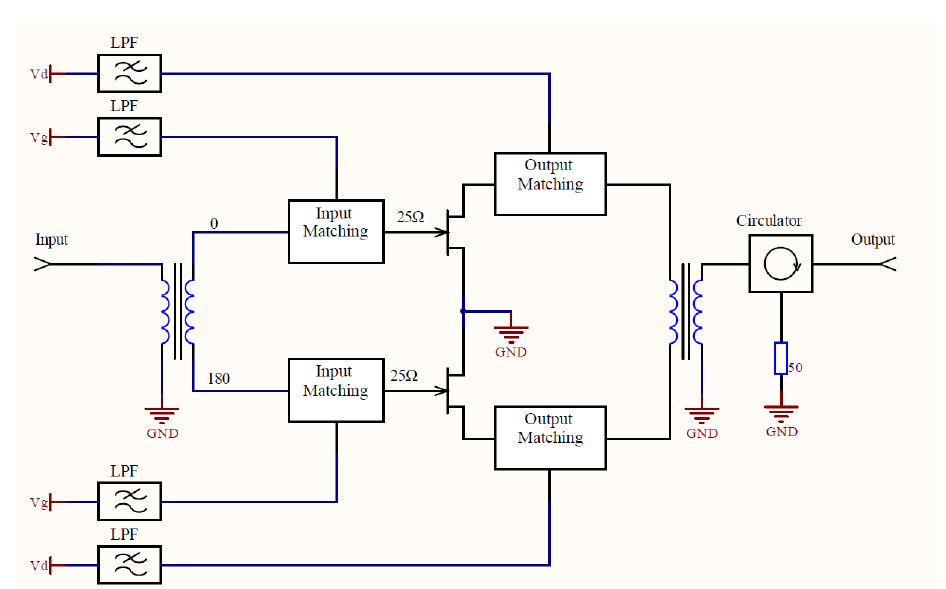
Fig. 1. Block diagram of the push-pull topology of the PA.